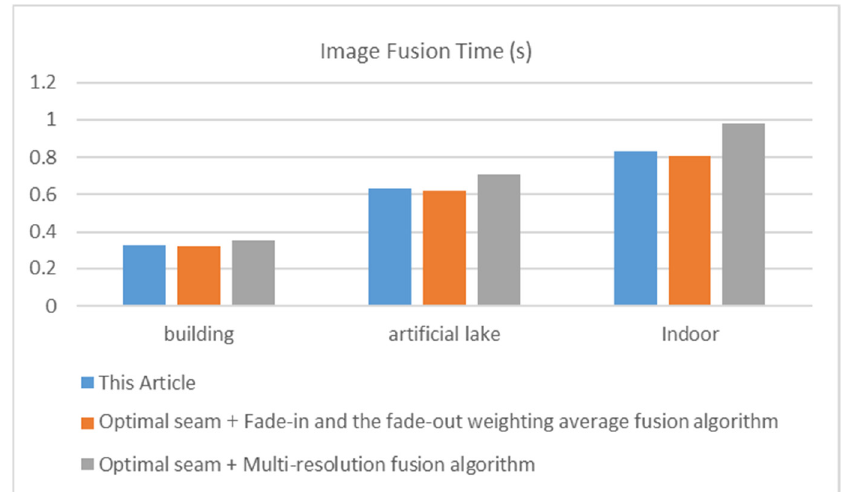
Figure 15. Comparison of image fusion time.